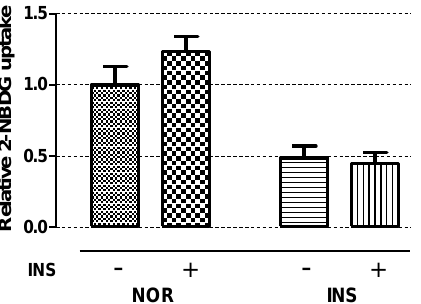
Figure 5. Insulin sensitivity test. 2-NBDG was used for measuring relative glucose uptake after treatment of 1 μM insulin for 1 h ( n = 20). “ + ” means 1 μM insulin is treated for 1 h and “ - ” means non-treated in both NOR and INS group as control for comparing 2-NBDG uptake.